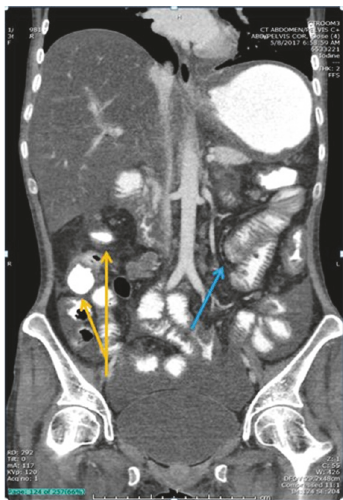
Figure 1: CT demonstrating concentric bowel wall thickening in the region of the splenic flexure (blue arrow) with sparing of the region of the hepatic flexure (yellow arrow). The patient later developed colonic obstruction at both sites.